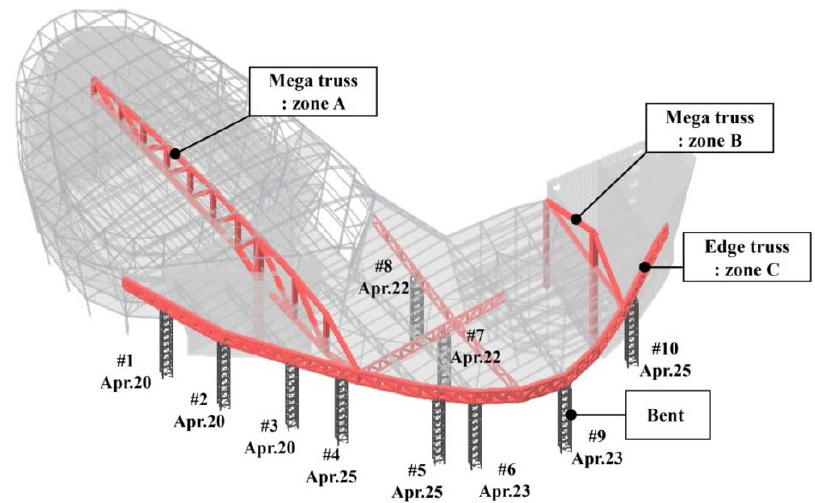
Figure 7. Removal schedule of temporary